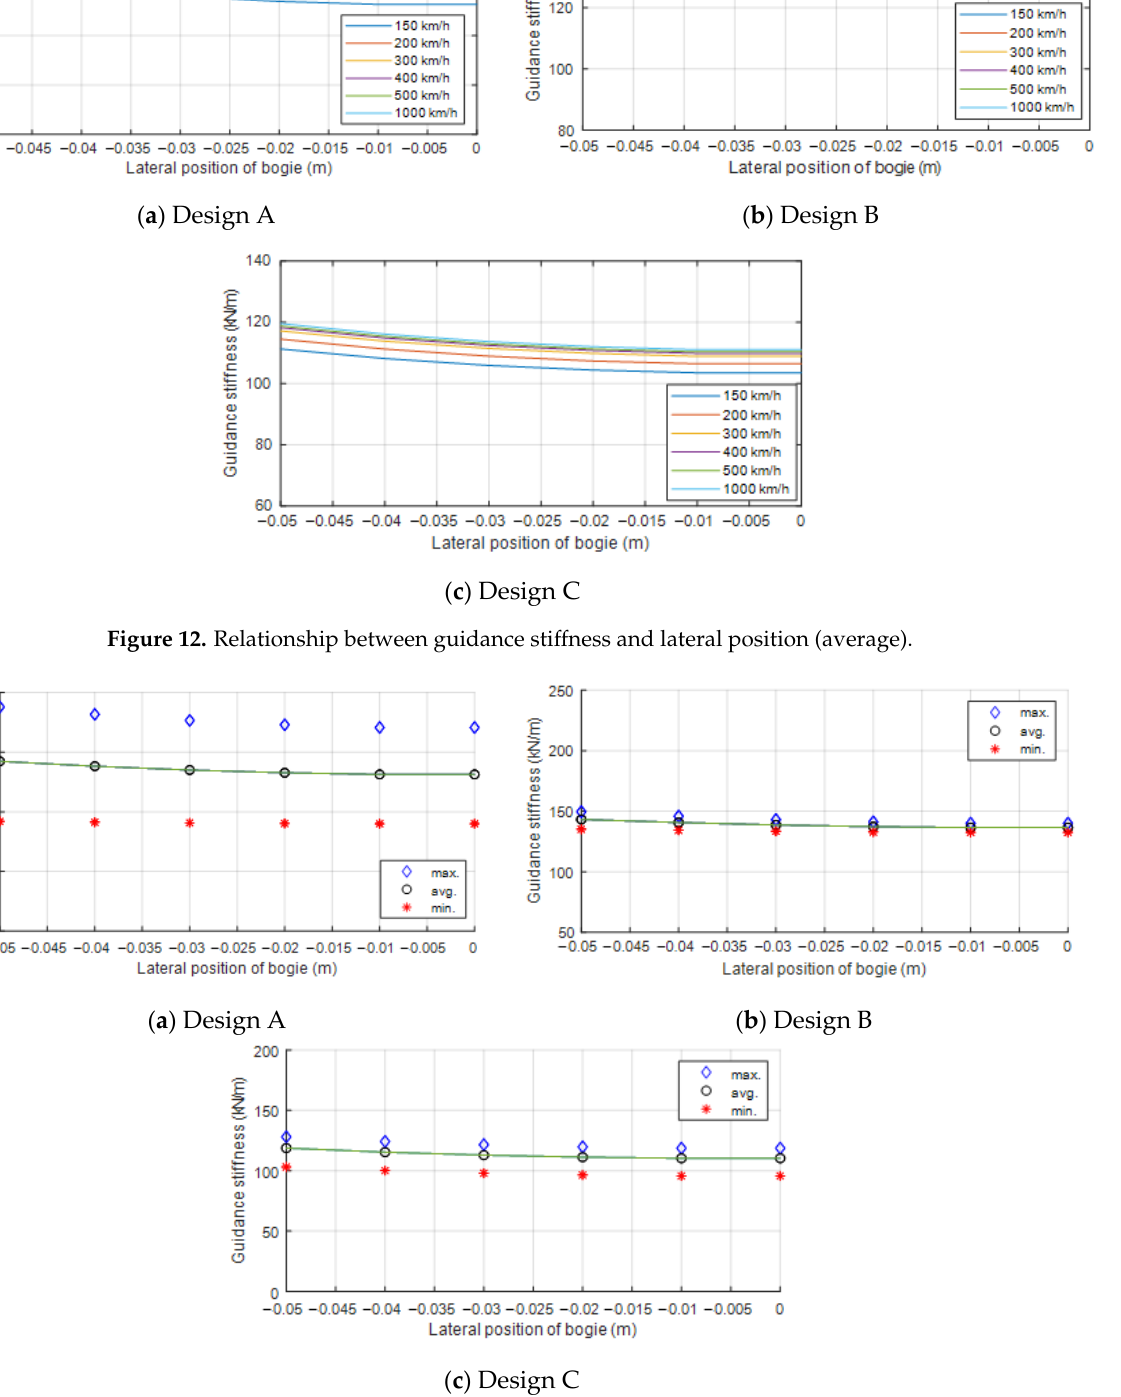
Figure 13. Relationship between the guidance stiffness and the lateral position (average and fluctuation).